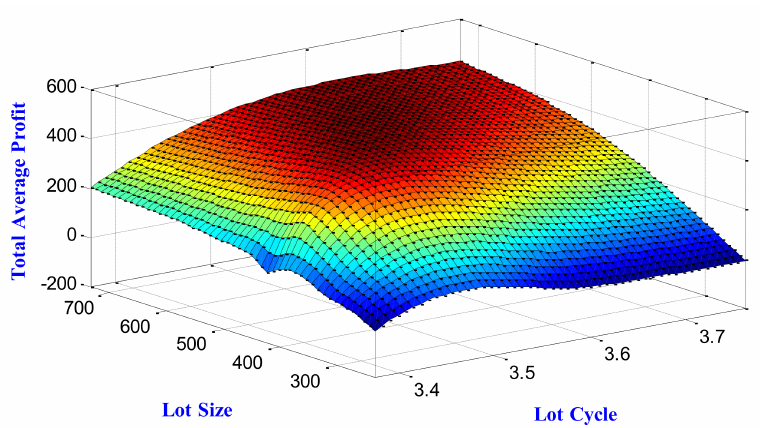
Figure 11. Three-dimensional dependency among total average profit, lot cycle and lot size for the case of shortage.